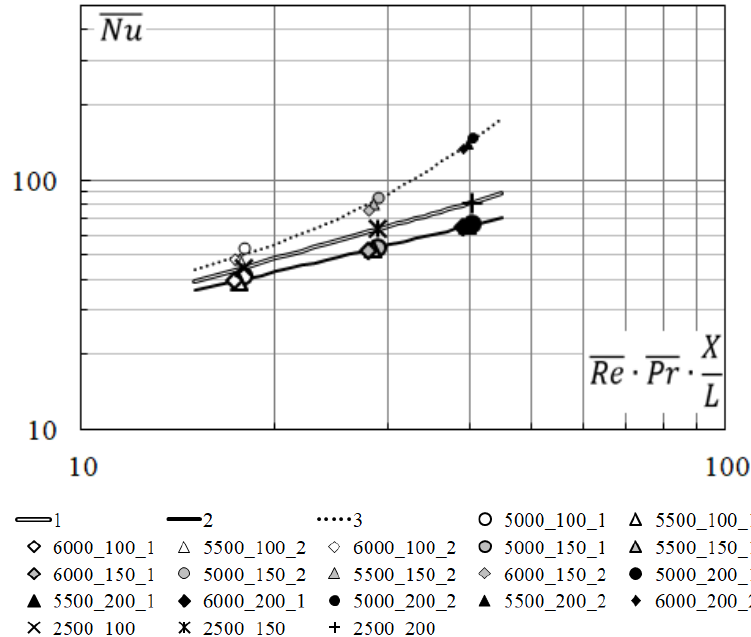
Figure 14. Generalizing dependences of average Nusselt numbers on the dimensionless coordinate. Curve 1—symmetrical two-sided heat input, curve 2—one-sided heat input, the hot surface; curve 3—one-sided heat input, the non-heated surface.